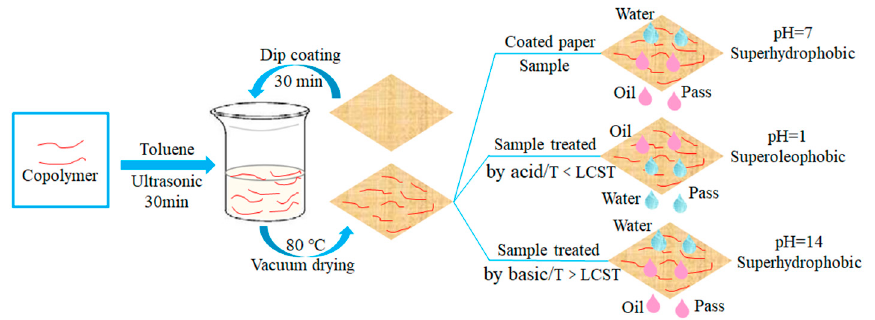
Figure 2. Synthesis procedure of temperature and pH dual-response superhydrophobic paper and its applications in oil/water separation under different temperature and pH treatments.